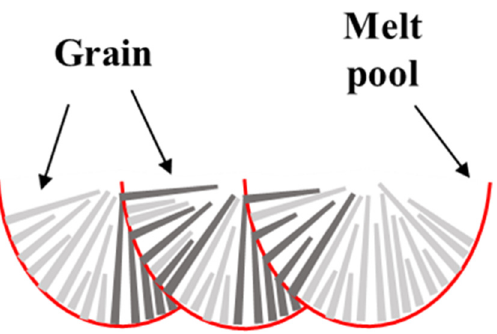
Figure 9. Schematic diagram of grain growth of the Cu–Cr–Nb–Ti alloy (dark gray grain represents the same grain).